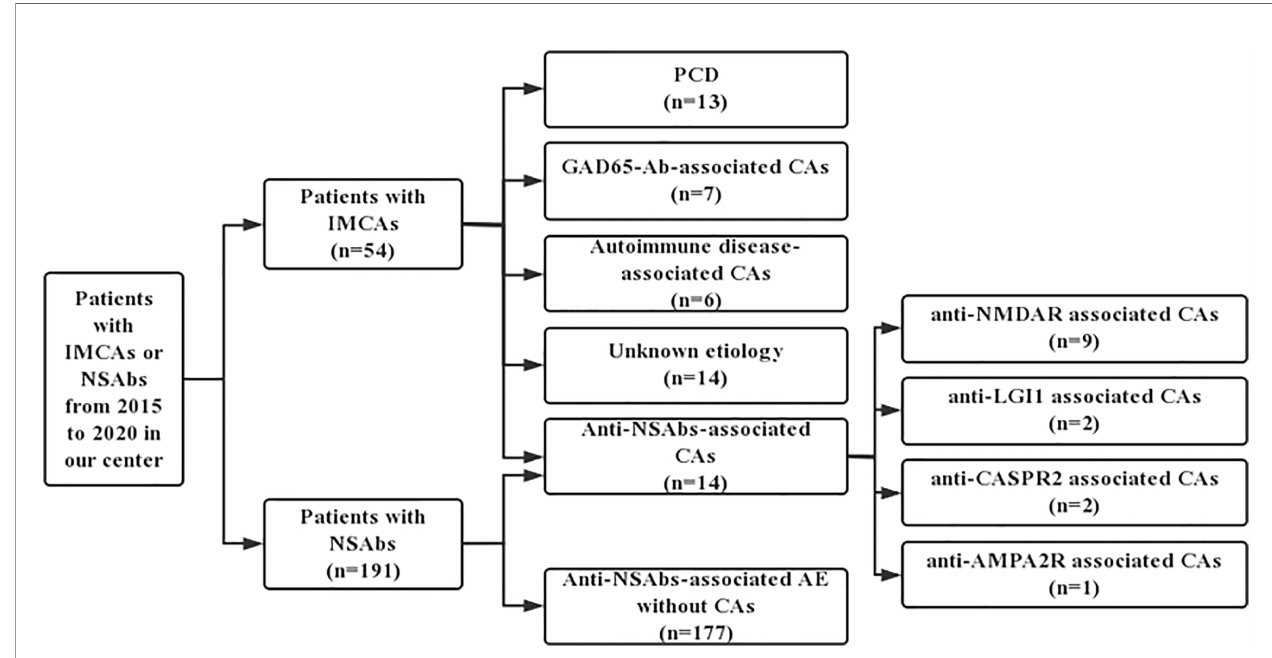
FIGURE 1 | The process of identifying patients from IMCAs and anti-NSAbs cohorts. NSAbs, Neuronal surface antibodies; NSAbs, Neuronal surface antibodies; PCD, Paraneoplastic cerebellar degeneration; AE, autoimmune